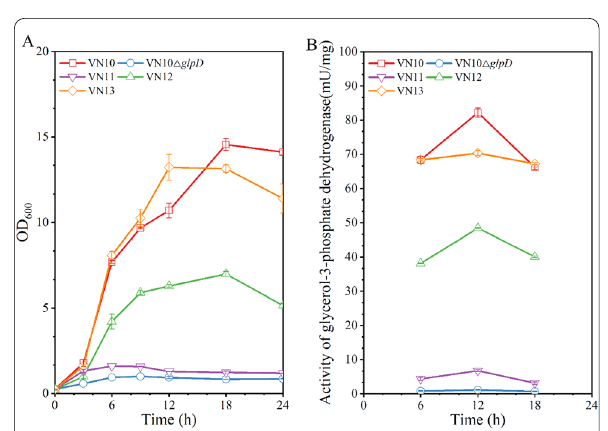
Fig. 3 Development of a plasmid maintenance system by adjusting the promoter of glpD gene in the expression vector. A Cell growth; B Activity of glycerol-3-phosphate dehydrogenase during the shake flask